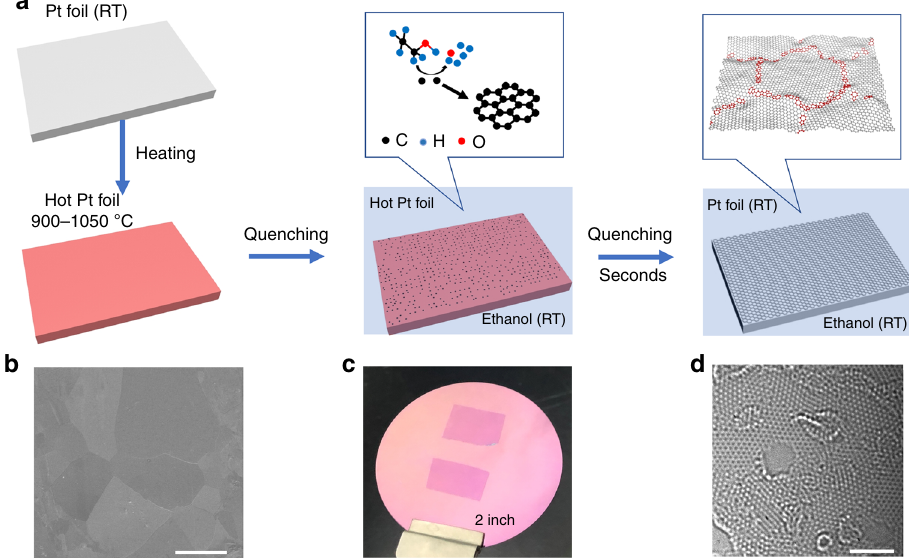
Fig. 1 Ultrafast synthesis of NG fi lm by ethanol quenching. a Schematic of the synthesis process of NG fi lm by quenching a hot Pt foil in ethanol at room temperature (RT). b Scanning electron microscopy (SEM) image of an as-grown NG fi lm on Pt substrate. The different contrasts represent the Pt grains with different orientations. c Two pieces of NG fi lms (~1 × 1.5 cm 2 ) grown on Pt foils with onset temperature of 1050 °C (top) and 900 °C (bottom), and then transferred onto SiO 2 /Si substrate. d Atomic-level HRTEM image of the graphene fi lm grown with an onset temperature of 900 °C, showing nanocrystalline structure. The strong adsorption ability of GBs leads to PMMA residues 5 . To expose the GBs, the samples were annealed at 320 °C in air for 8 h to remove the adsorbed PMMA residues, which simultaneously generates some holes. Scale bars: b 100 μ m; d 2